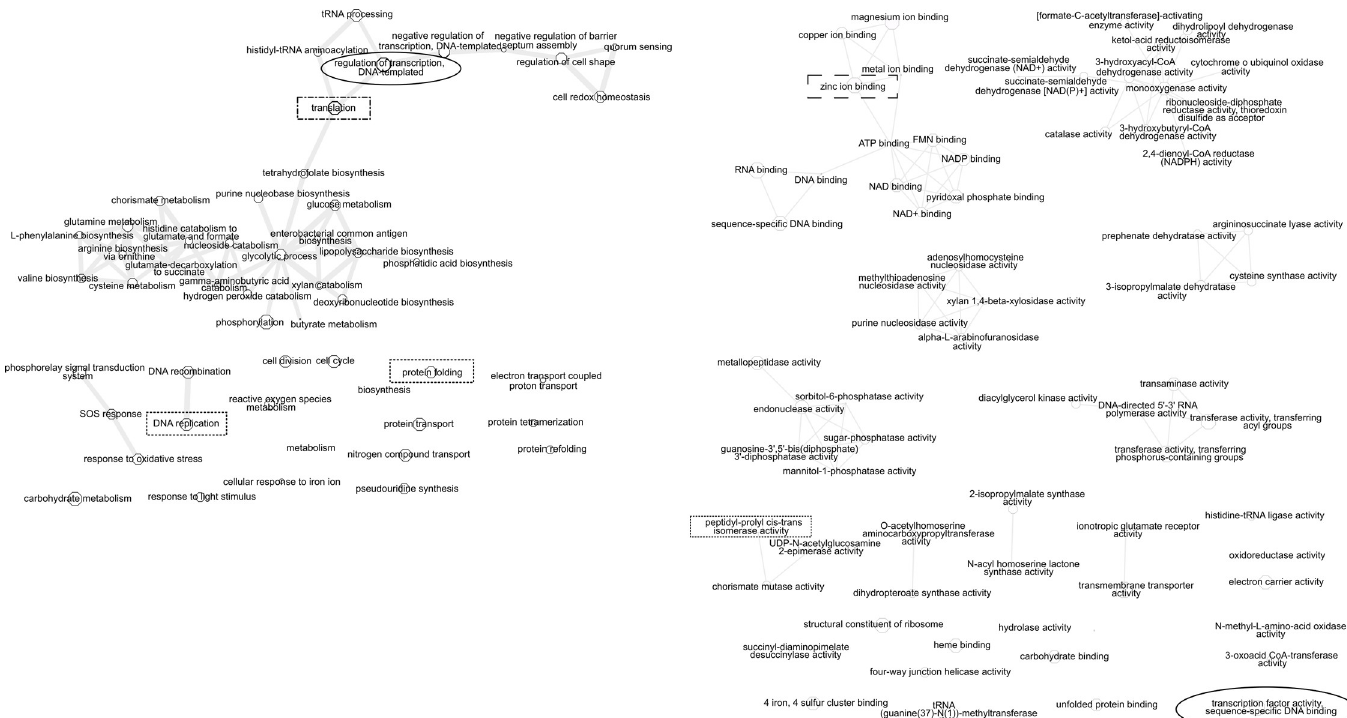
Fig 2. Network visualization of Gene Ontology process and function annotation differences between normal water and drought treatments at the DE site. Significant Gene Ontology (GO) annotations from ENNB analysis were grouped by semantic similarity into a network. The size of each node is proportional to the frequency of annotation relative to the GO database. Similar terms are linked with edges. Circles and boxes indicate terms shared between field sites. a) DE field site GO Process annotations that were significantly different between fully watered and drought microbial phyllosphere samples. b) DE field site GO function annotations that were significantly different between fully watered and drought microbial phyllosphere